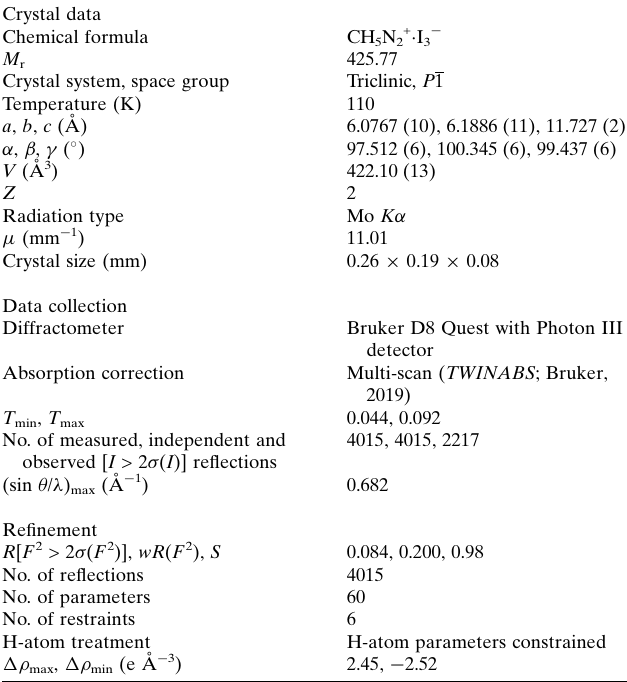
Table 3 Experimental details. Crystal data Chemical